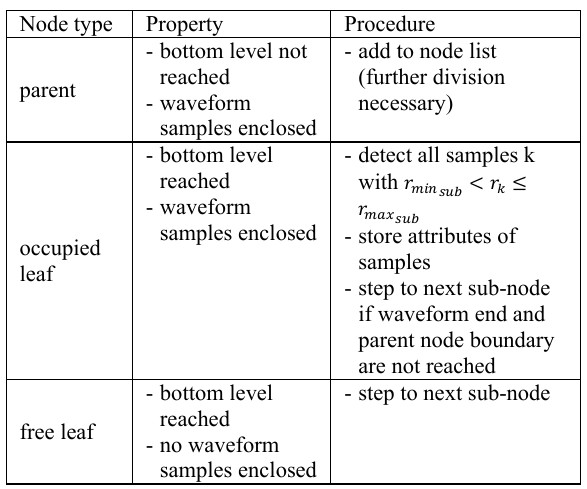
Table 2. Properties and procedure for the different node types